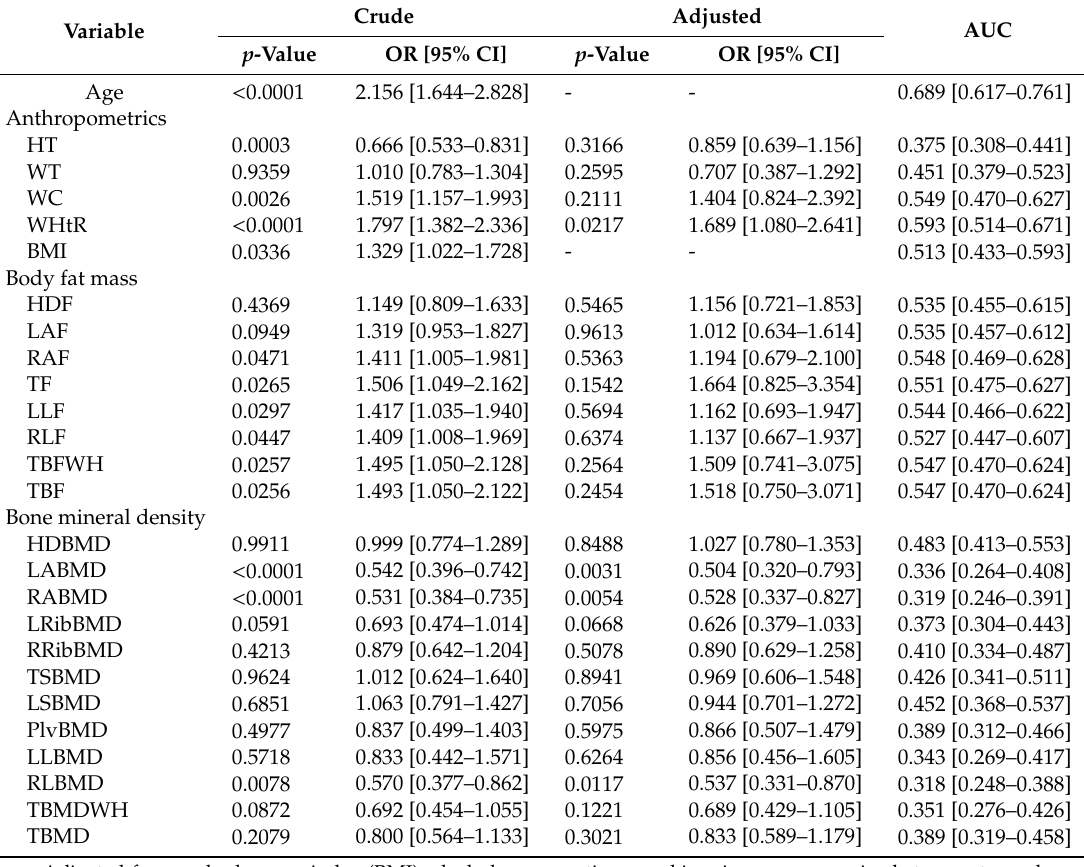
Table 5. Comparison of anthropometric and body composition indices in men with both hypertension and